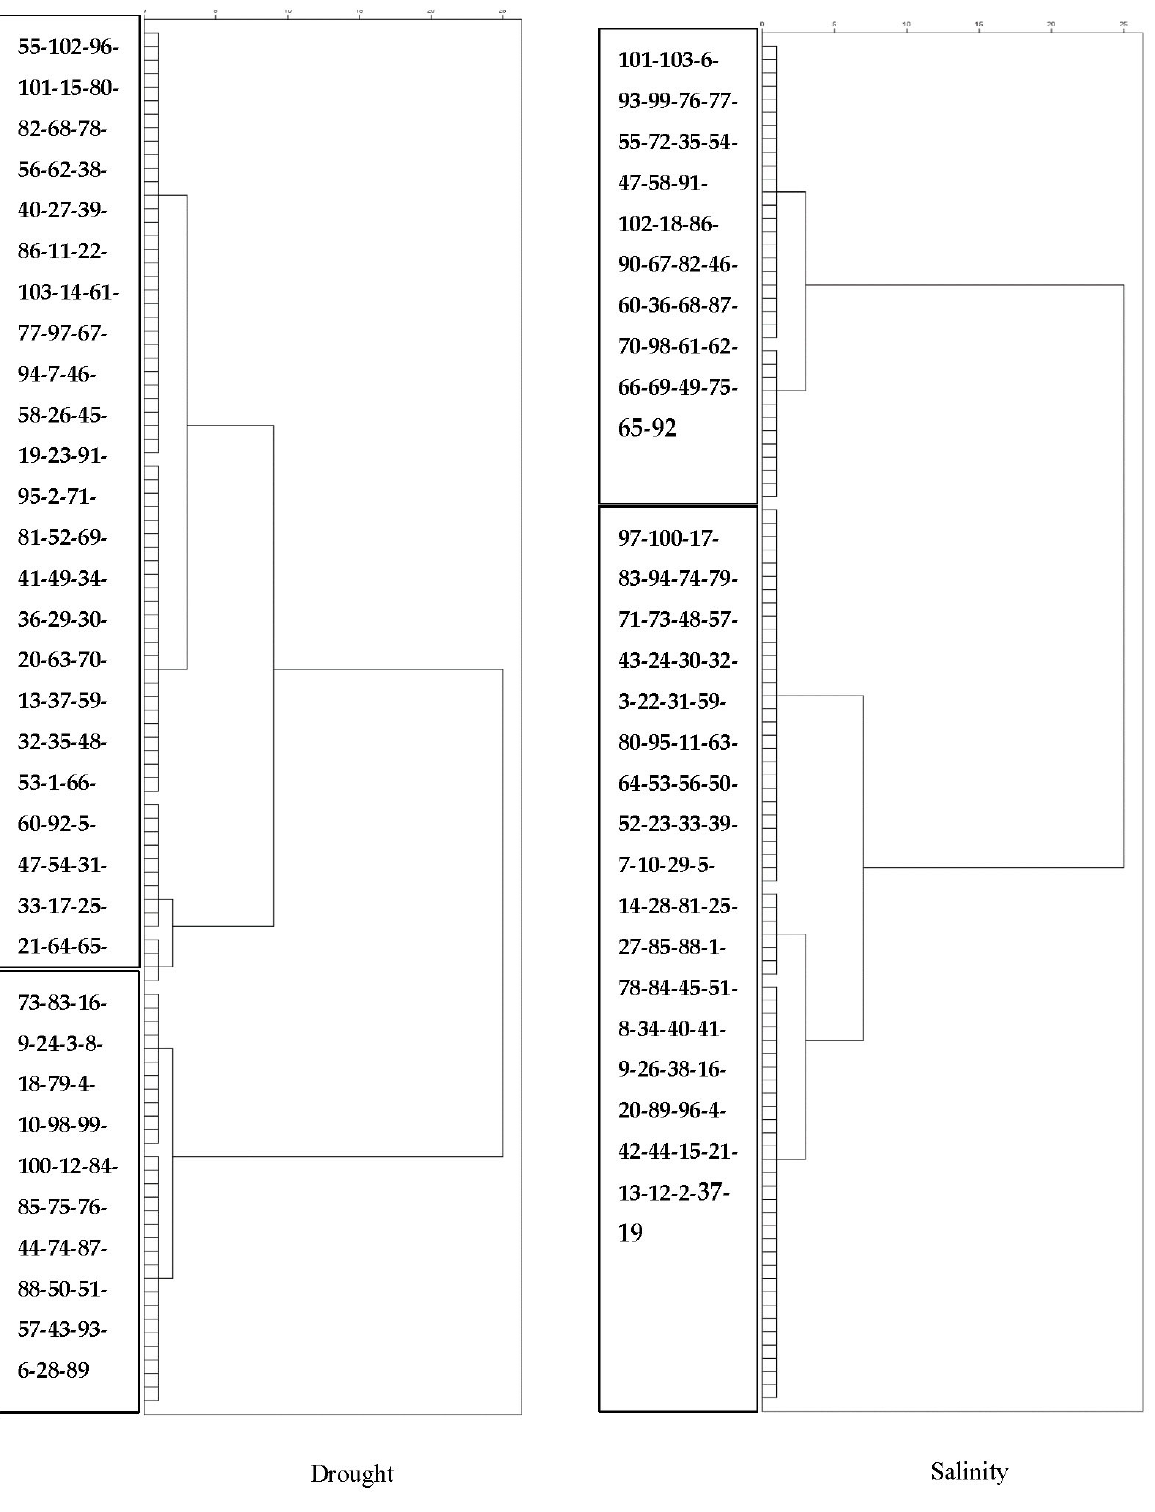
Figure 2. Dendrogram based on the genetic code under salinity and drought stress conditions.